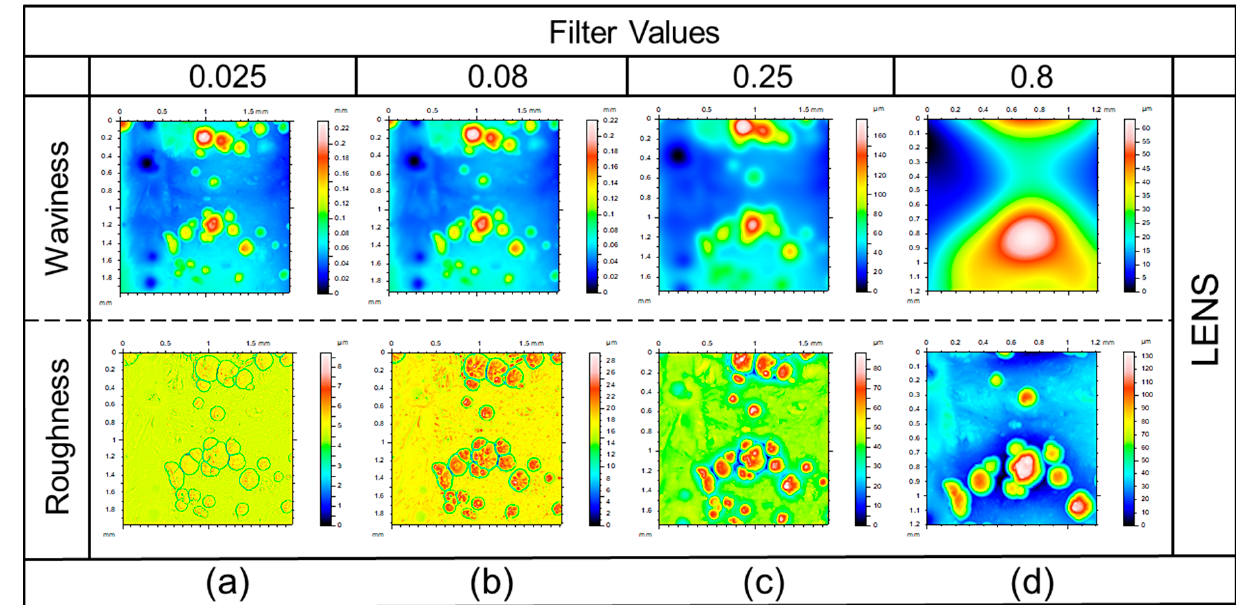
Figure 10. Surface topography of as-built EBM surface after filtering.